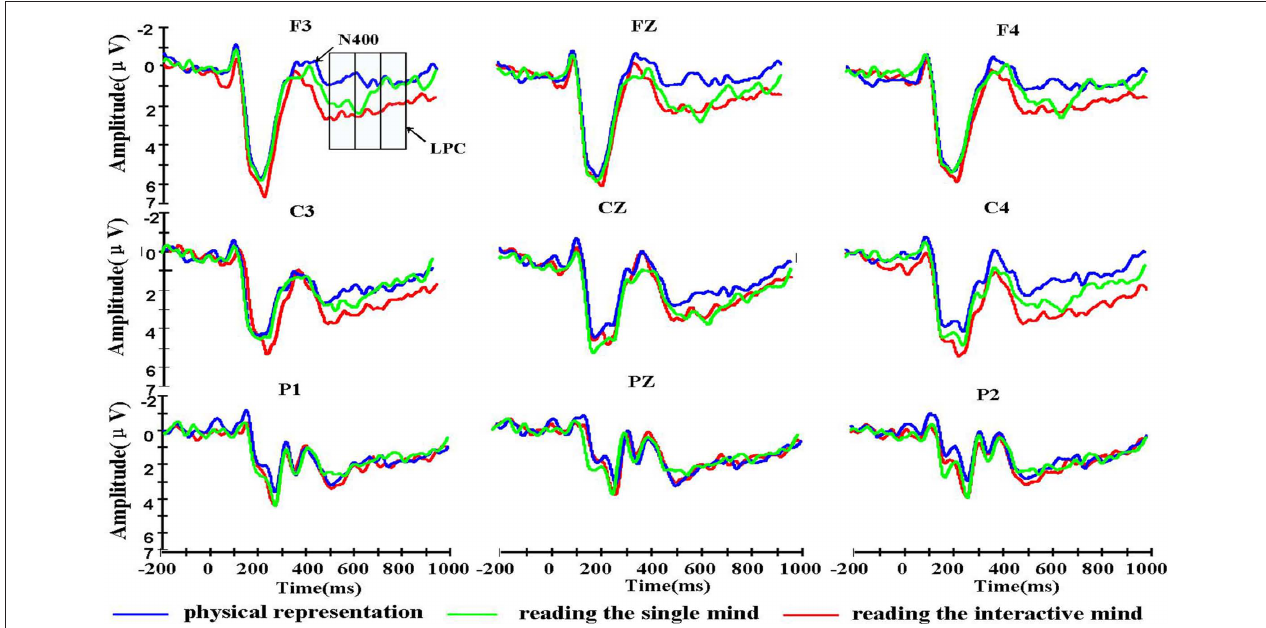
FIgure 1 | grand average event-related brain potential waveforms for the three types of Chinese idioms of physical representation, reading the single mind, and reading the interactive mind from nine